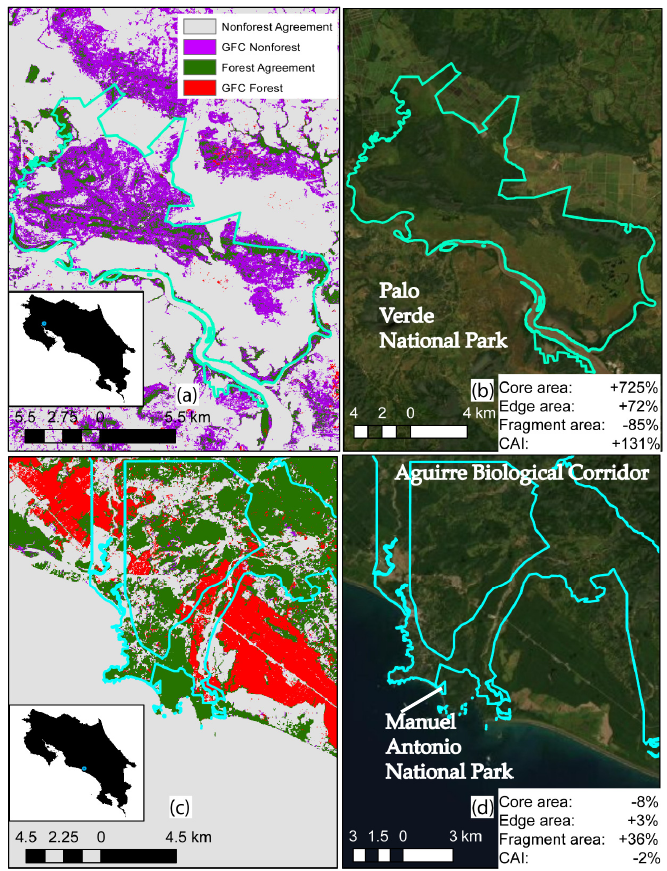
Figure 13. Selected examples of changes in tree cover from GFC map correction in Costa Rica, in a protected area (panels a , b ), and a biological corridor (panels c , d ). Conservation area boundaries are show by the blue lines, purple land cover indicates forest increases after correction, and red land cover indicates forest declines after correction (see Figure 8e). The impact of the GFC correction on fragmentation and connectivity metrics in each conservation area is shown in the white boxes (see text for details). High-resolution imagery (panels b , d ) shown from ESRI and Maxar. able to revise the dry tropical forest cover estimates by as much as 70% while leaving wet tropical